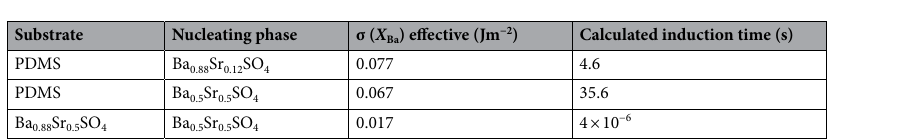
suppressed. It can thus be inferred that the precipitation of Ba 0.5 Sr 0.5 SO 4 is controlled by processes that are kineti- cally slower and which are not included in the presented model, e.g., nucleation processes.